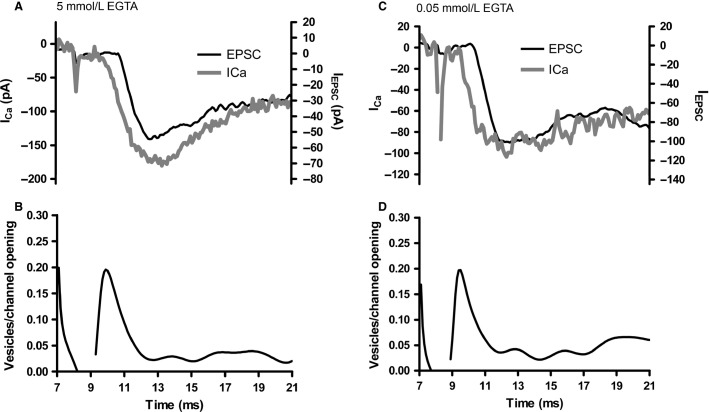
Effects of Ca2+ buffering on rod release efficiency. (A) Rod Ca2+ current (ICa, gray, left axis) and overlaid EPSCs (black, right axis) in response to a depolarizing step (–79 to –19 mV, 100 msec). The rod pipette solution contained 5 mmol/L EGTA and ICa was recorded with a P/8 leak subtraction protocol. The inward current deflection at ˜8 msec is an artifact from incompletely compensated pipette capacitance and did not influence the efficiency measurement. (B) The number of vesicle fusion events per Ca2+ channel opening measured by deconvolving both the EPSC and ICa. The peak efficiency for this recording was 0.2 vesicles/channel opening. (C) Overlaid EPSC and ICa recorded from a rod-HC cell pair in which the rod patch pipette solution contained 0.05 mmol/L EGTA to mimic endogenous Ca2+ buffering. (D) The peak efficiency for this recording was 0.2 vesicles/channel opening, similar to the 5 mmol/L EGTA recording.